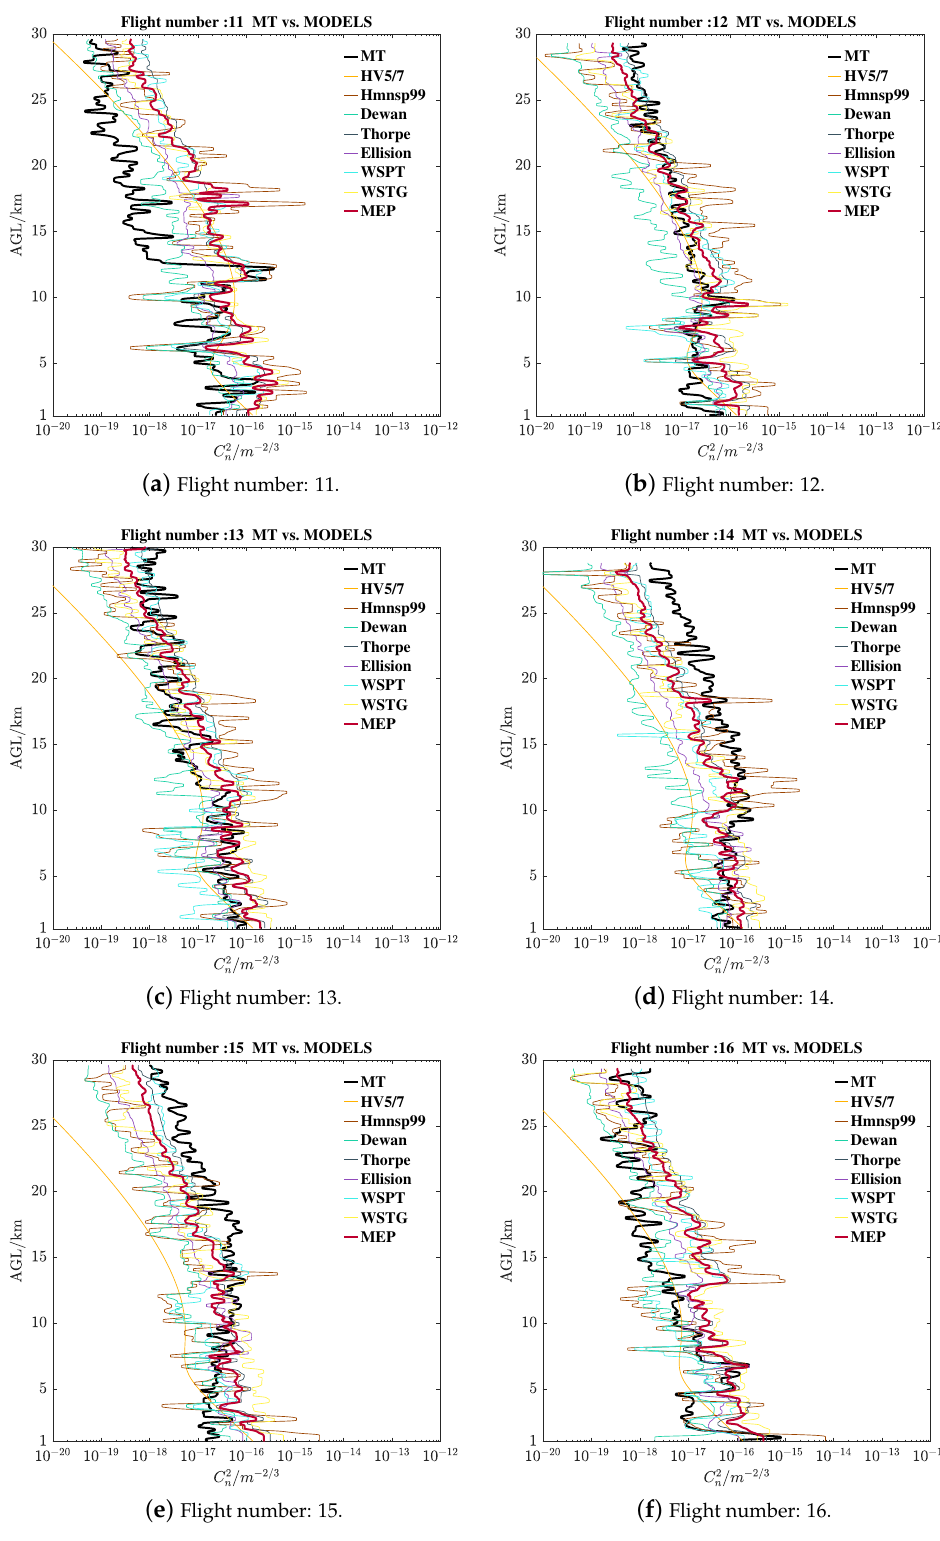
Figure A6. The refractive index structure parameter profiles of MT and estimations in NCACN: Figure A6 sub-figures ( a – f ) are flight numbers 11–16 in Table